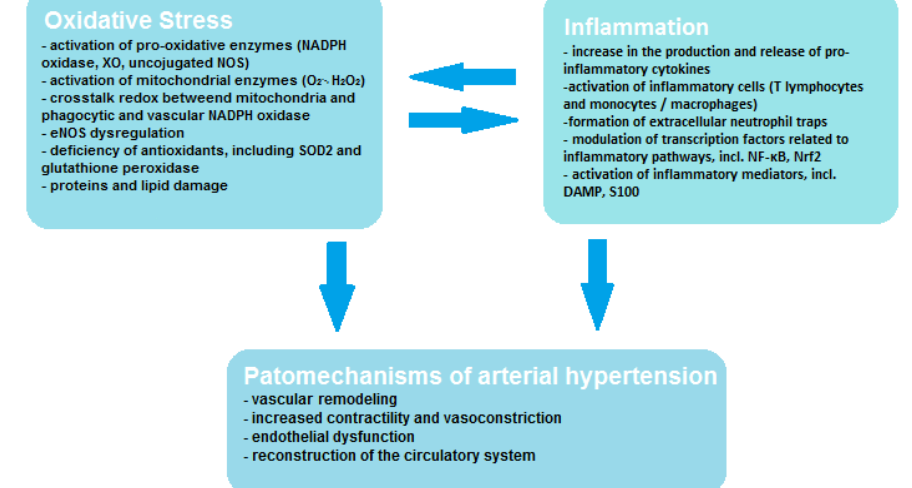
Figure 1. Correlation between oxidative stress, inflammation and hypertension.